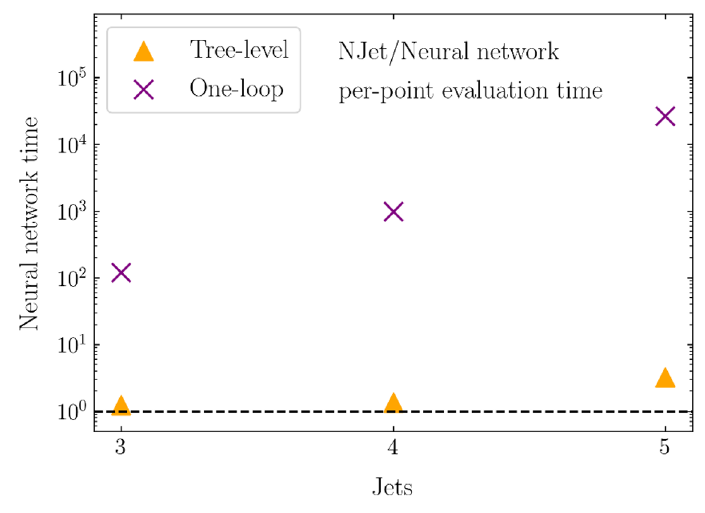
Figure 1 . A comparison of the CPU cost of tree-level and one-loop amplitudes to a generic neural network (Keras/TensorFlow) as a function of the number of legs (equivalently number of